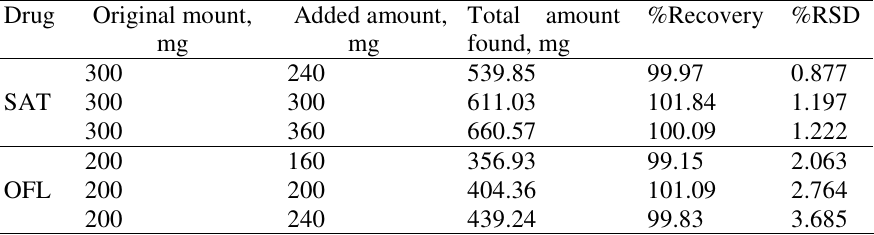
Table 2. Recovery studies of satranidazole and